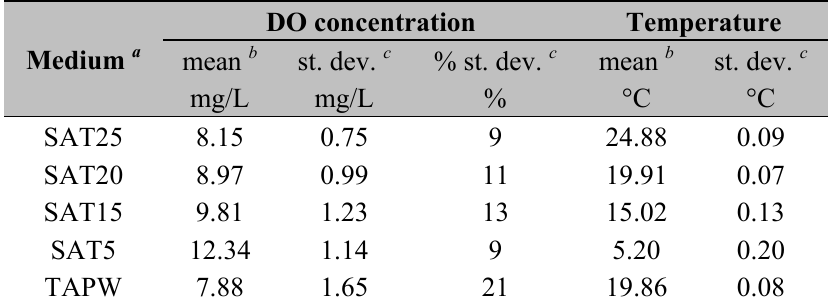
Table 4. The mean values of the participating laboratories and their absolute and relative standard deviations.